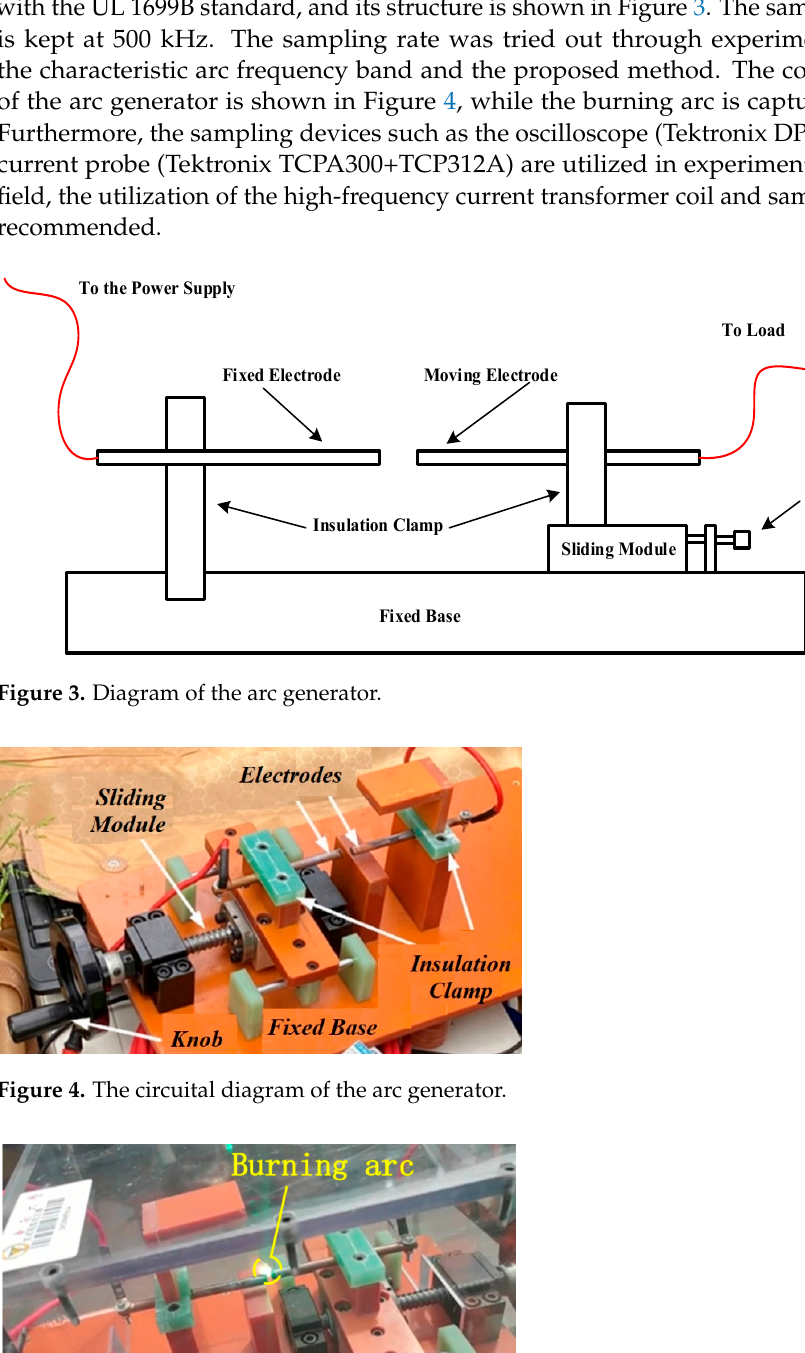
Figure 2. Schematic diagram of the series arc experimental platform.